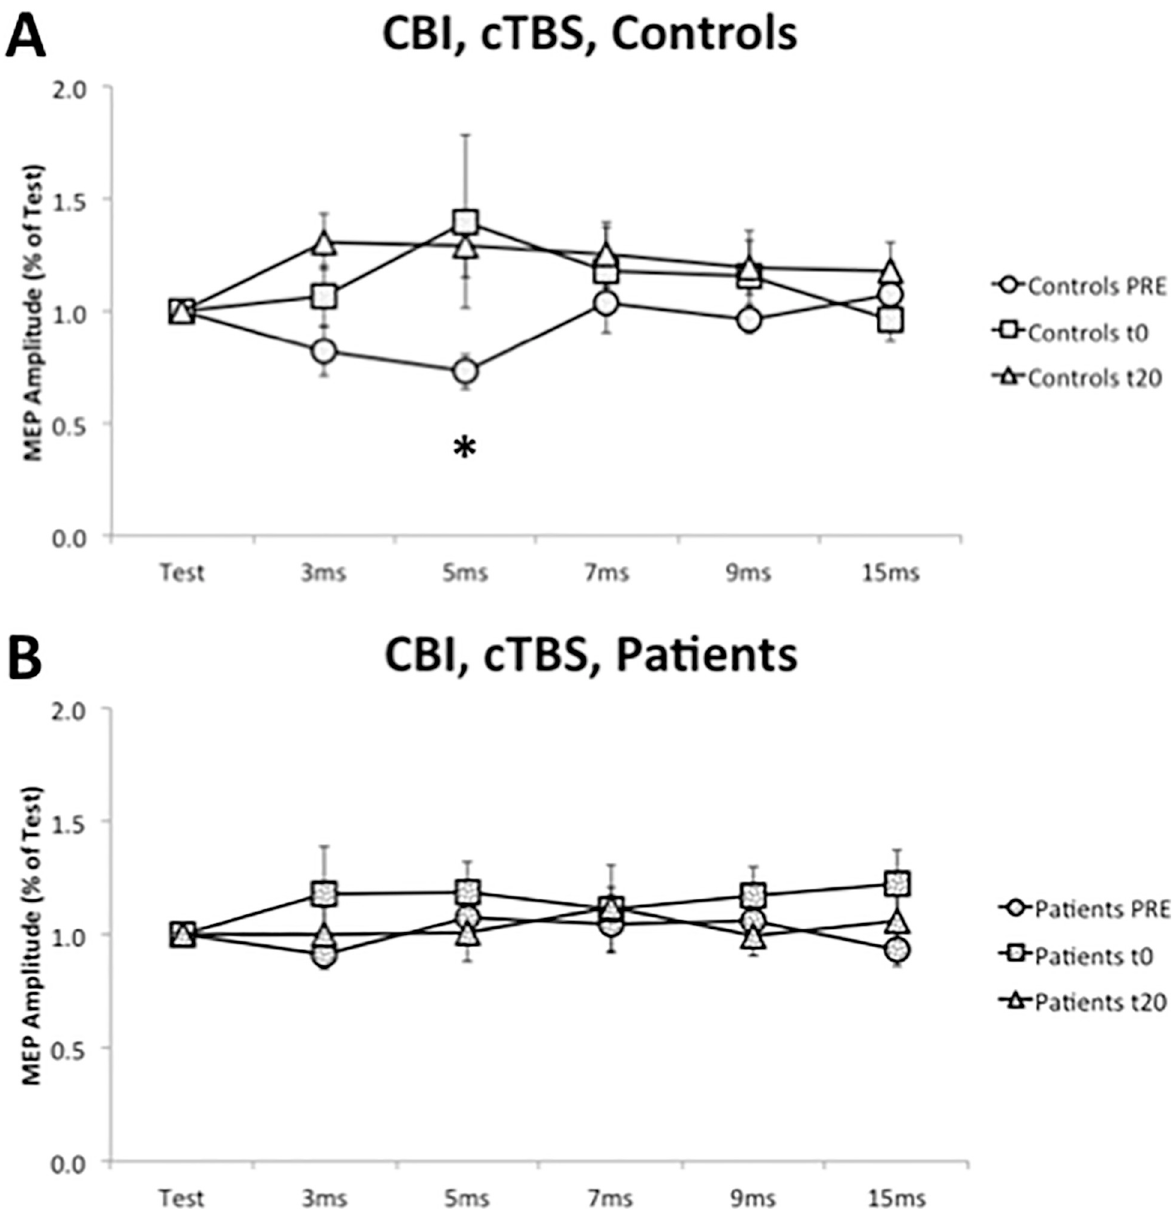
Fig 5. Effects of cerebellar cTBS on cerebellar cortical inhibition (CBI) in controls (A) and patients (B). PRE: before cTBS; t0: immediately after cTBS; t20: 20 minutes after cTBS. Horizontal axis: Test stimulus and the different inter-stimuli intervals. � : P < 0.05. Error bars represent the standard